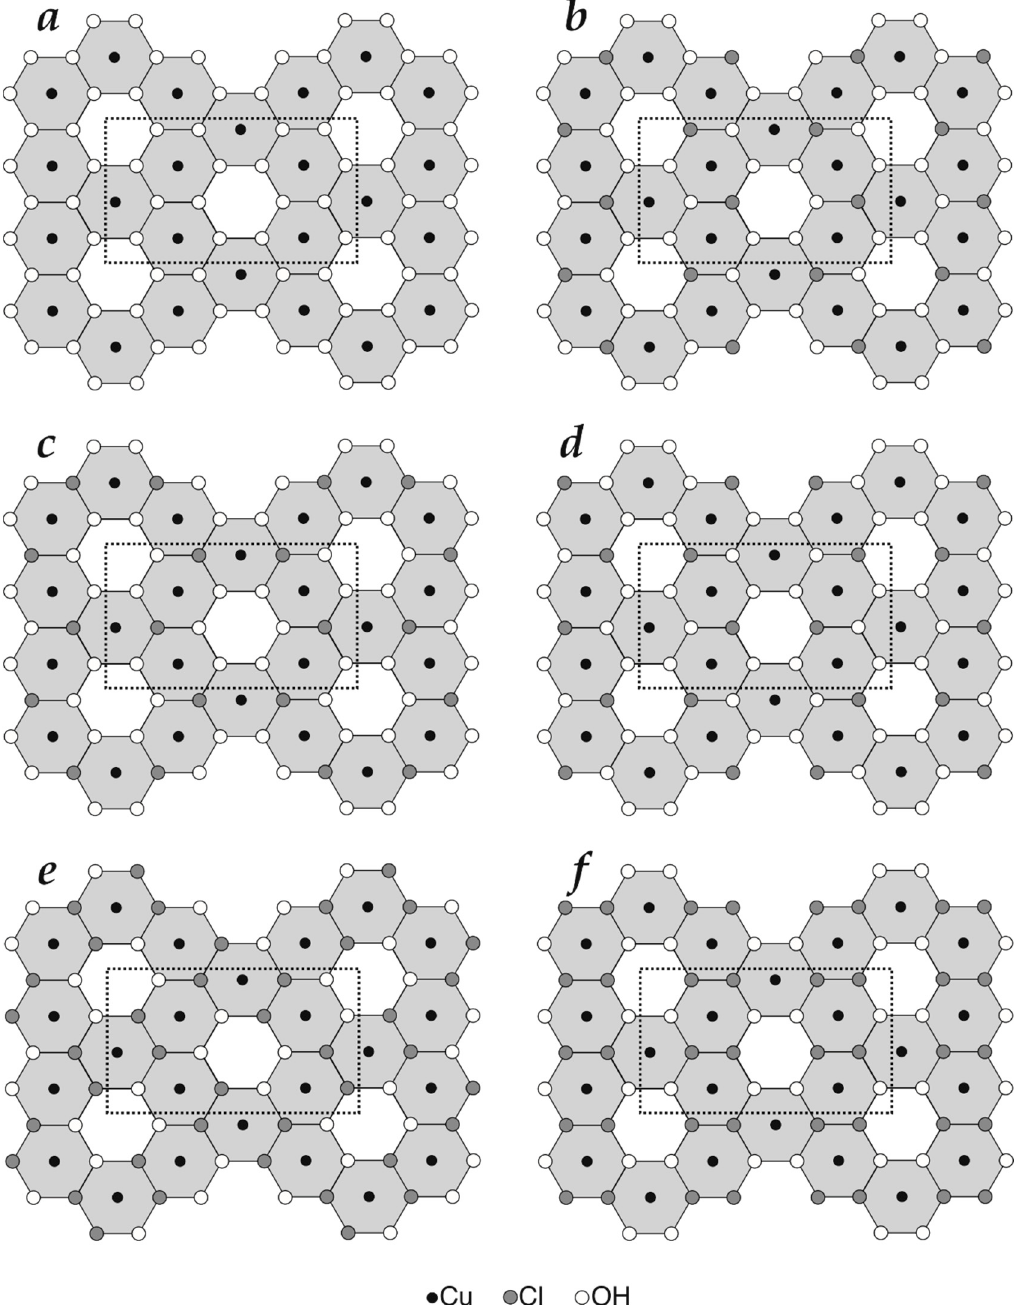
Figure 10. The idealized model of the [Cu 3 φ 8 ] layer ( φ = Cl, OH) ( a ) and the schemes of the OH/Cl population in the crystal structures of atacamite ( b ), clinoatacamite ( c ), bobkingite ( d ), avdoninite ( e ) and dioskouriite polytypes ( f ).